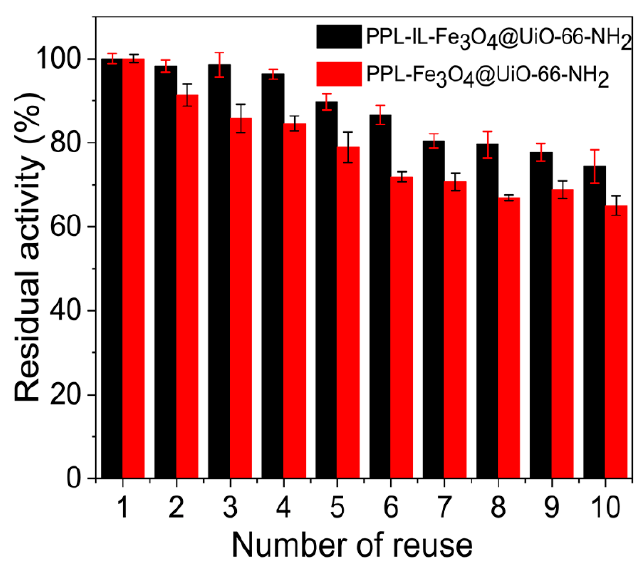
Figure 6. Reusability of the immobilized PPL for 10 cycles.